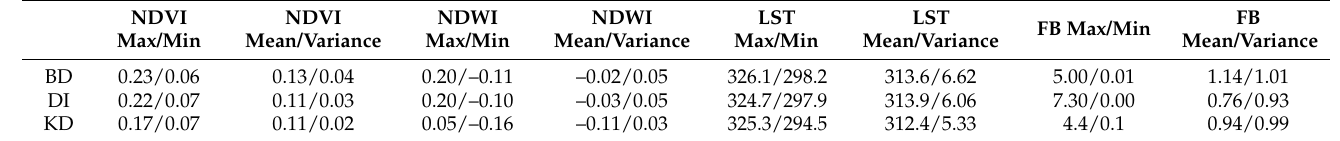
Table 4. Statistical results for the NDVI, NDWI, LST, and FB for